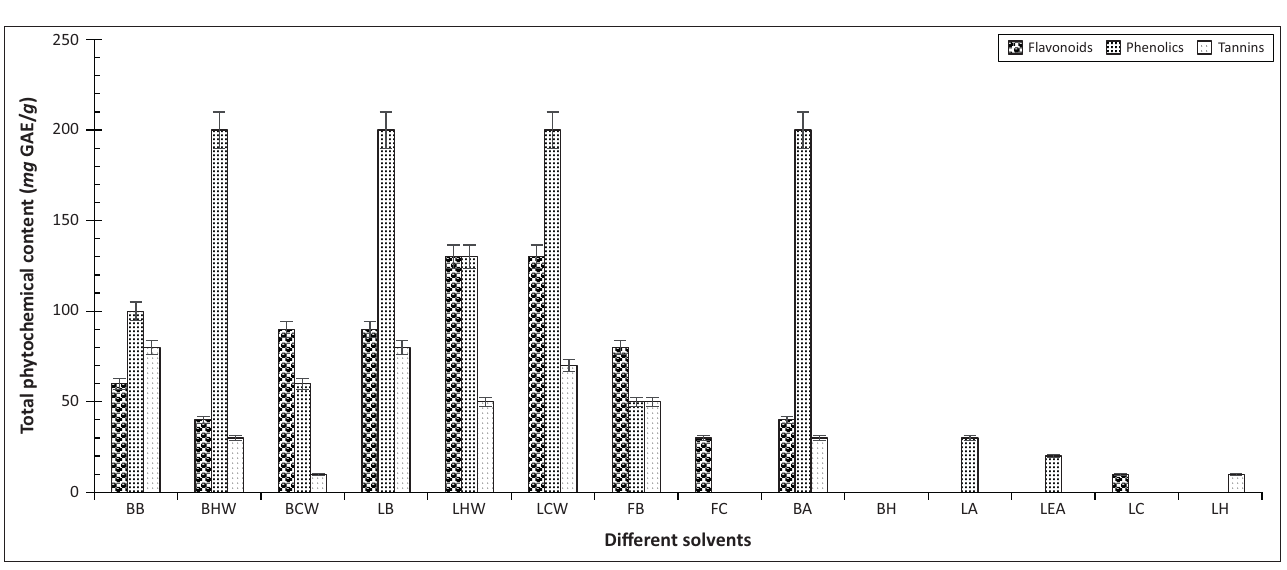
FIGURE 1: Total flavonoids (mg quercitin E/g), total phenolic and total tannin (mg GAE/g) contents of leaf, bark and fruit extracts of C. grandicalyx.